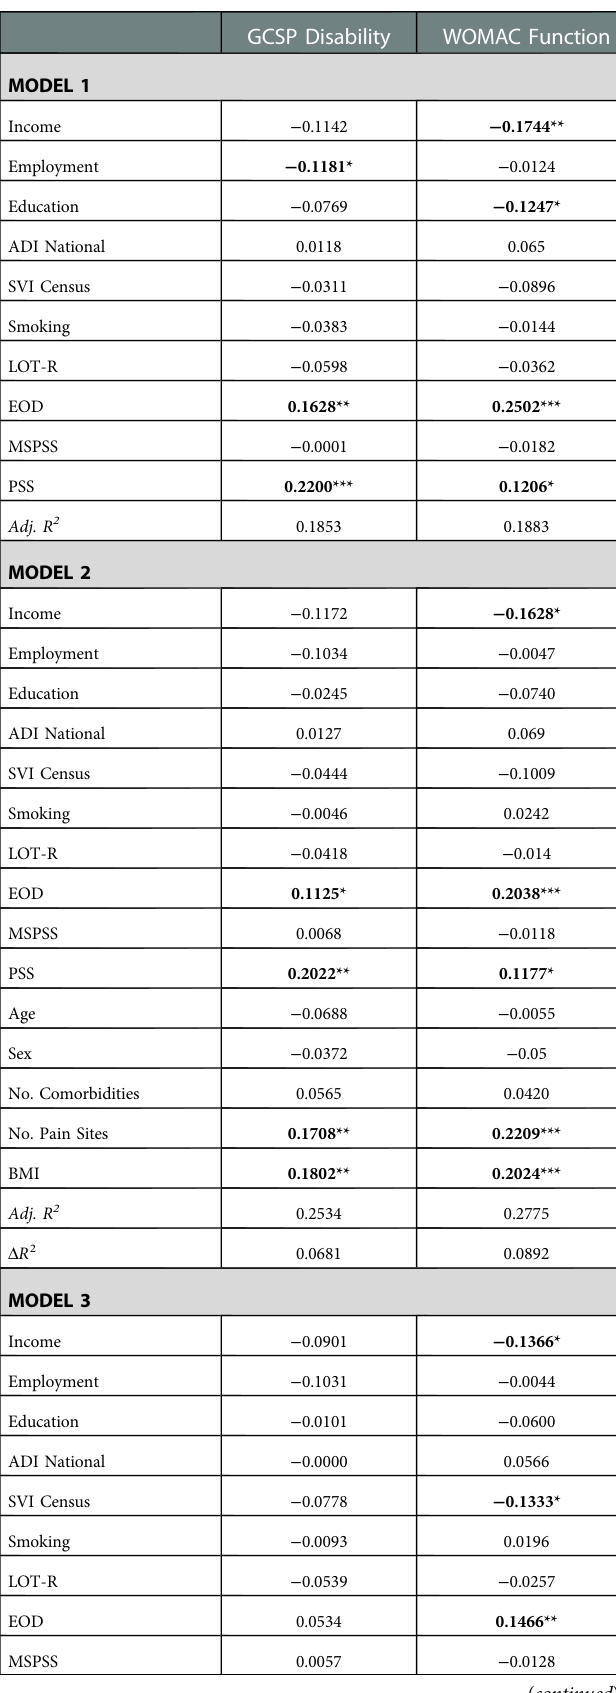
TABLE 3 Nested linear regression models assessing environmental and behavioral factors on physical